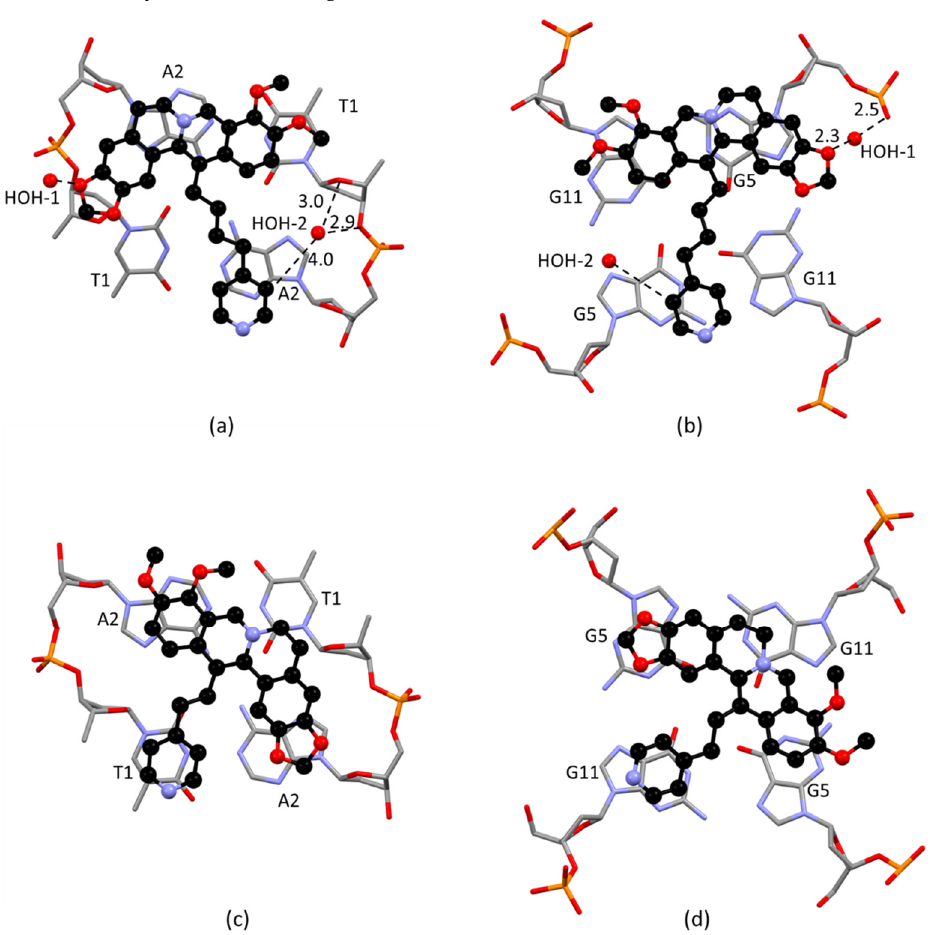
Figure 4. Details of the contacts established in the crystal structures of 2 /Tel12 and 4 /Tel12 viewed along the four ‐ fold screw axis (c axis) on top of the 5 ′‐ end TATA tetrad—( a ) ( 4 ) and ( c ) ( 2 )—and on top of the 3 ′‐ end GGGG tetrad—( b ) ( 4 ) and ( d ) ( 2 ).